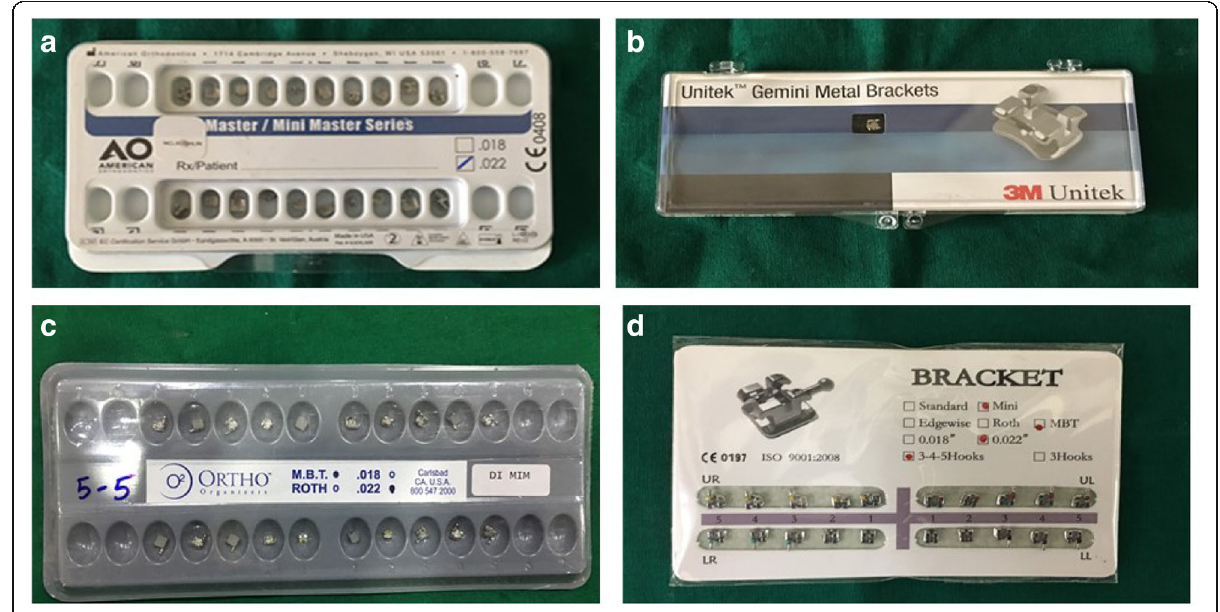
Fig. 1 Orthodontic bracket kits. a American Orthodontics brackets. b 3M Unitek. c Ortho Organizers. d China Dental Orthodontic